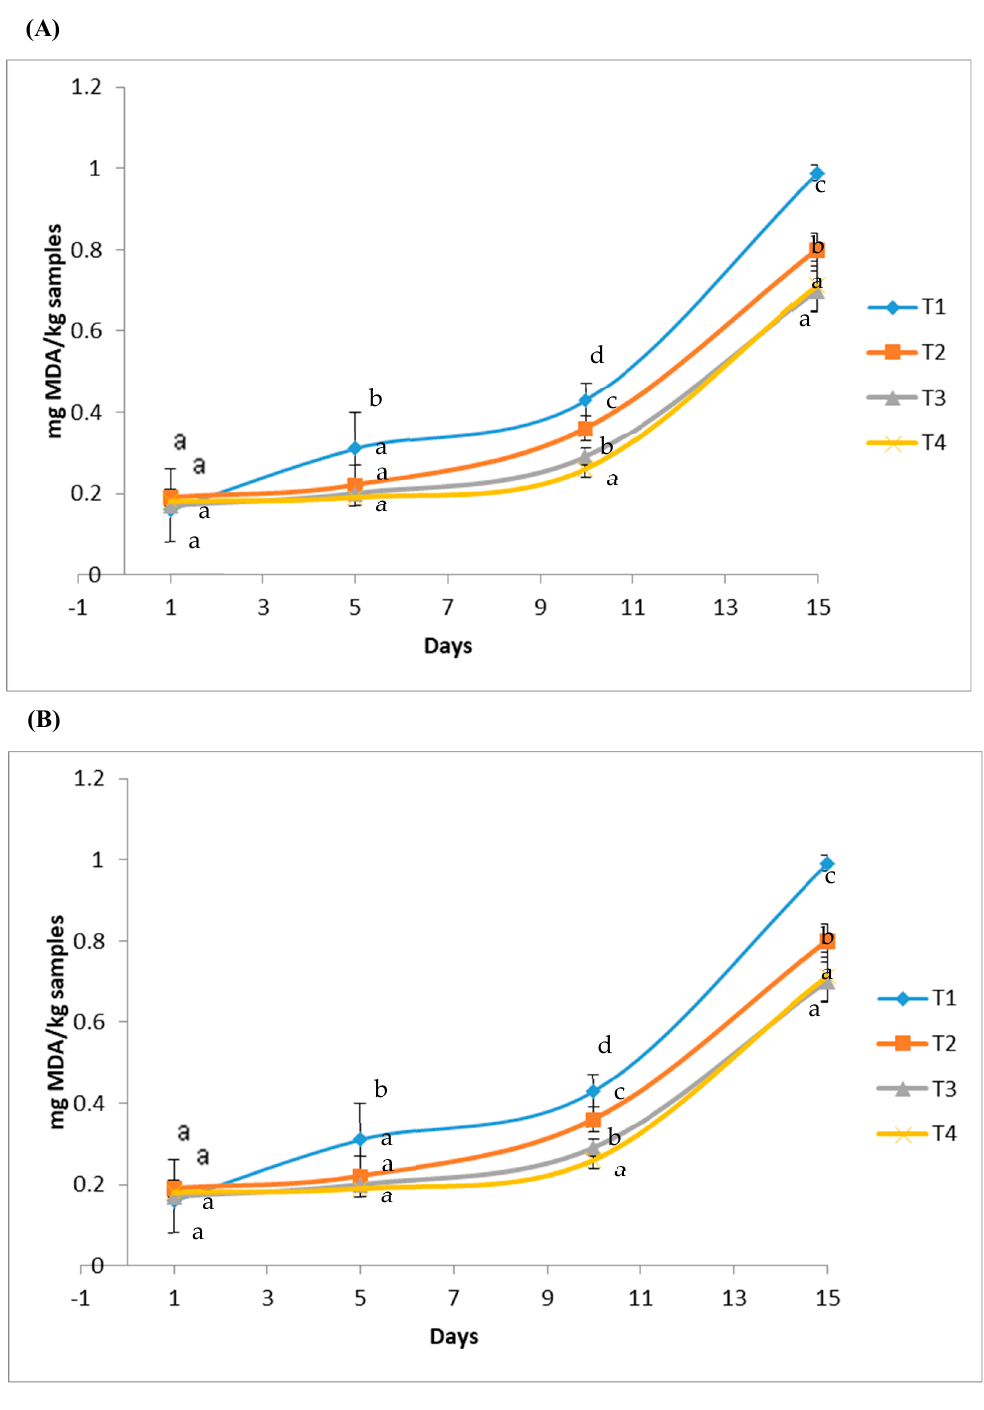
Figure 5. ( A ) Lipid oxidation (TBARS mg MDA/kg sample) values of different sausages during refrigerated storage. ( B ) Oxymyoglobin (%) of different sausages during refrigerated storage. T1: control sausage which did not contain either LWSP or ascorbic acid; T2: standard formulation consisting of 0.125% of ascorbic acid; T3: sausage reformulated with LWSP at 0.125% and T4: sausage reformulated with LWSP at 0.062% and ascorbic acid at 0.062%. Different letters refer to significant differences ( p < 0.05) between samples.